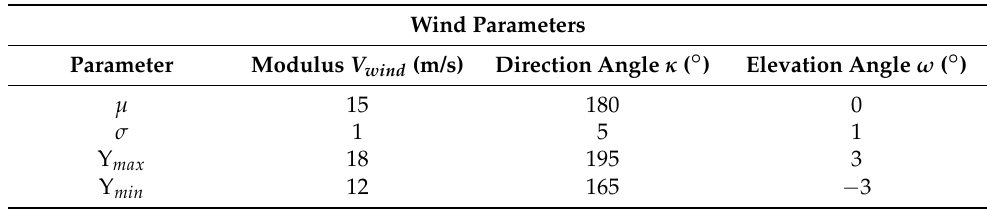
Table A1. The wind parameters employed to build the wind model: µ (mean), σ (standard deviation), and Υ max (maximum) and Υ min (minimum) values.